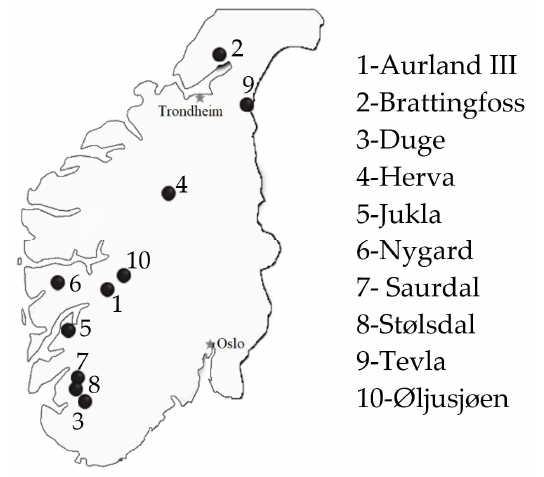
Figure 1. Map of pumped storage plants (PSPs) in